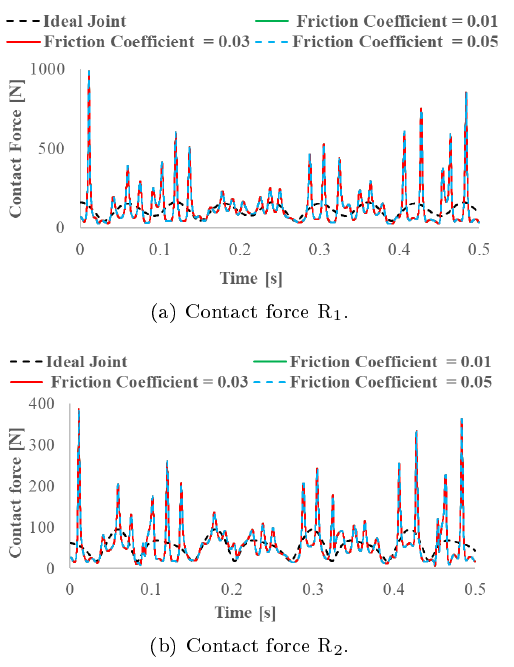
(b) Contact force R 2 . Fig. 11: Contact force at di(cid:27)erent friction coe(cid:30)cient.